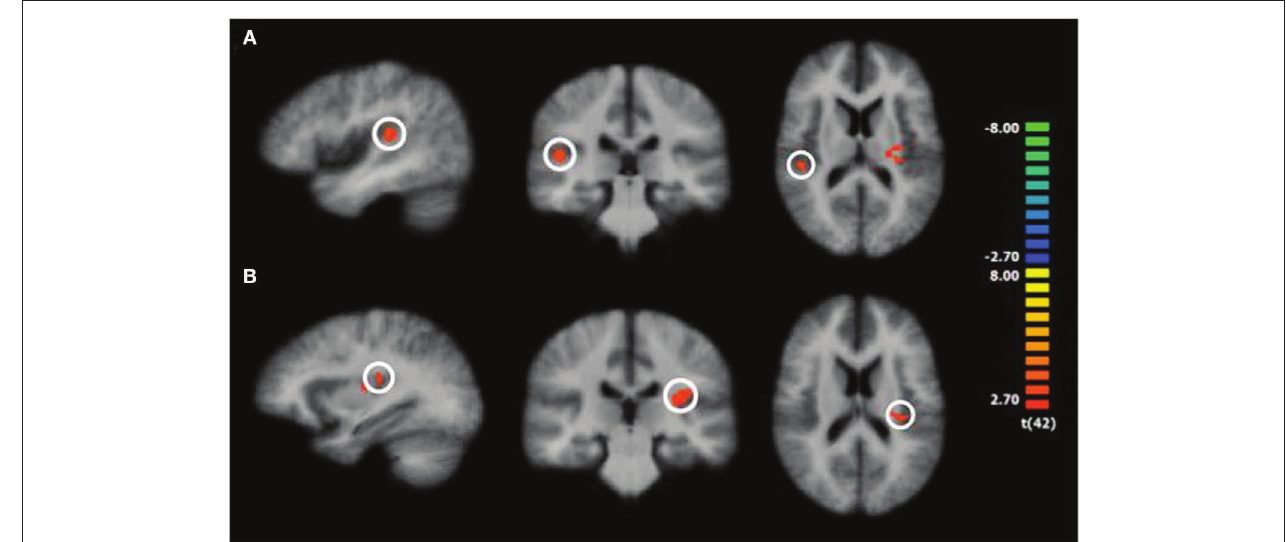
FIGURE 2 | Significantly increased activation in the insula following the time prime compared to the money prime. Note:The color bar shows the t -values; colors from red to yellow indicate activation increases, and colors